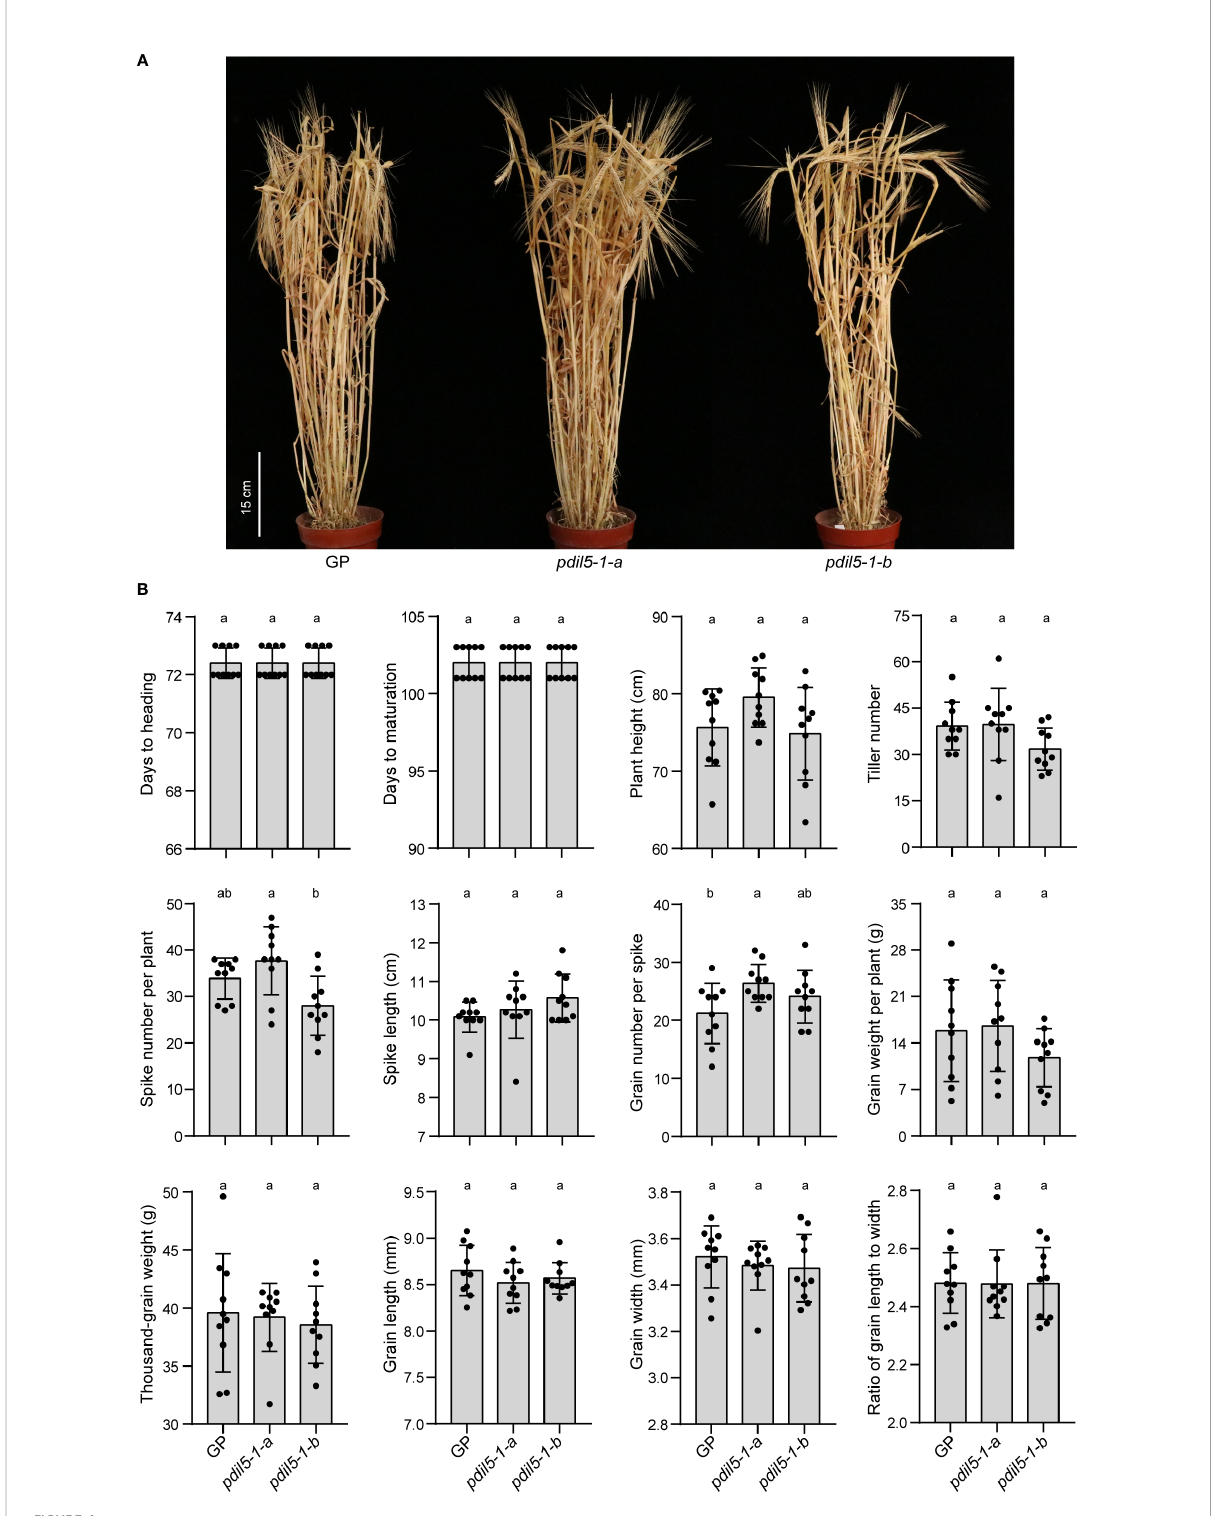
FIGURE 4 Agronomic performance of the HvPDIL5-1 -edited mutants under normal conditions in a garden experiment. (A) Wild type (GP) and pdil5-1 plants at the maturity stage. (B) Assessment of wild type and pdil5-1 plants. Statistical analysis was performed using Tukey ’ s post hoc ANOVA ( p < 0.05); different letters on bars indicate statistically signi fi cant differences. Ten plants per genotype were analyzed, and black dots represent individual measurements. Error bars =